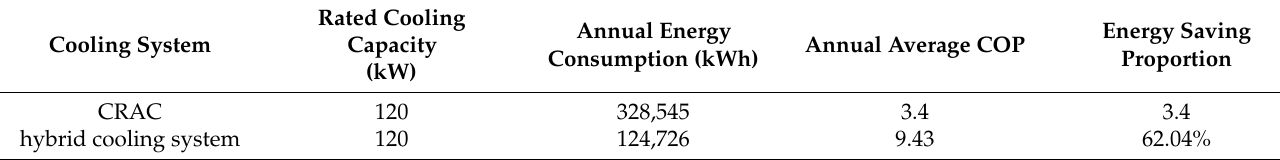
Table 10. Comparison of annual energy